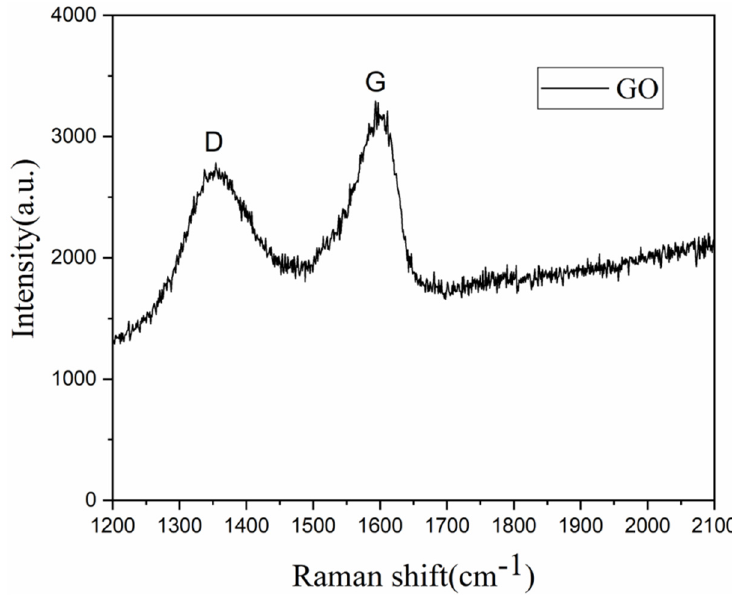
Figure 2. Raman spectra of the prepared GO.